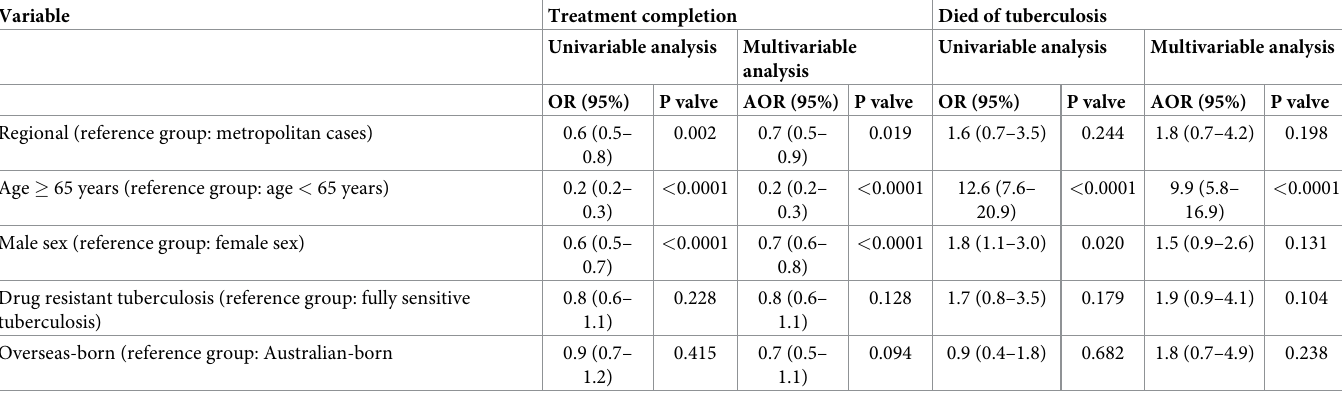
Table 3. Univariable and multivariable analysis of predictors of treatment completion and dying of tuberculosis from 2005 to 2019. Variable